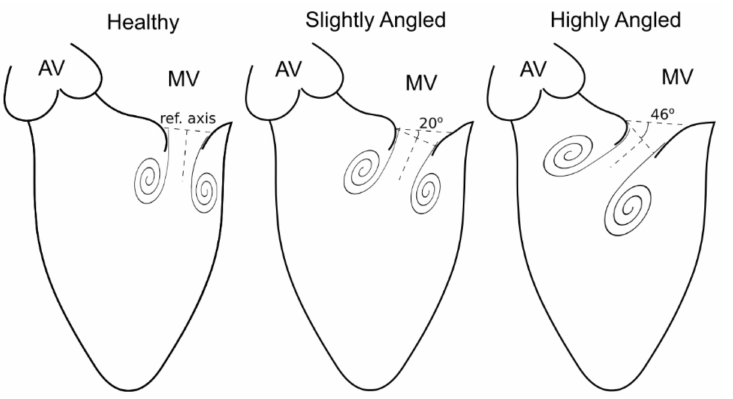
Figure 3. Mitral inflow for the healthy, slightly angled, and highly angled cases. The healthy inflow corresponds to a jet that is aligned with the apex such that the clockwise vortex swirls around the apex. The least severe case is oriented at an angle of 20 ◦ , using the orientation of the healthy case as a reference axis. The most severe case is tilted at an angle of 46 ◦